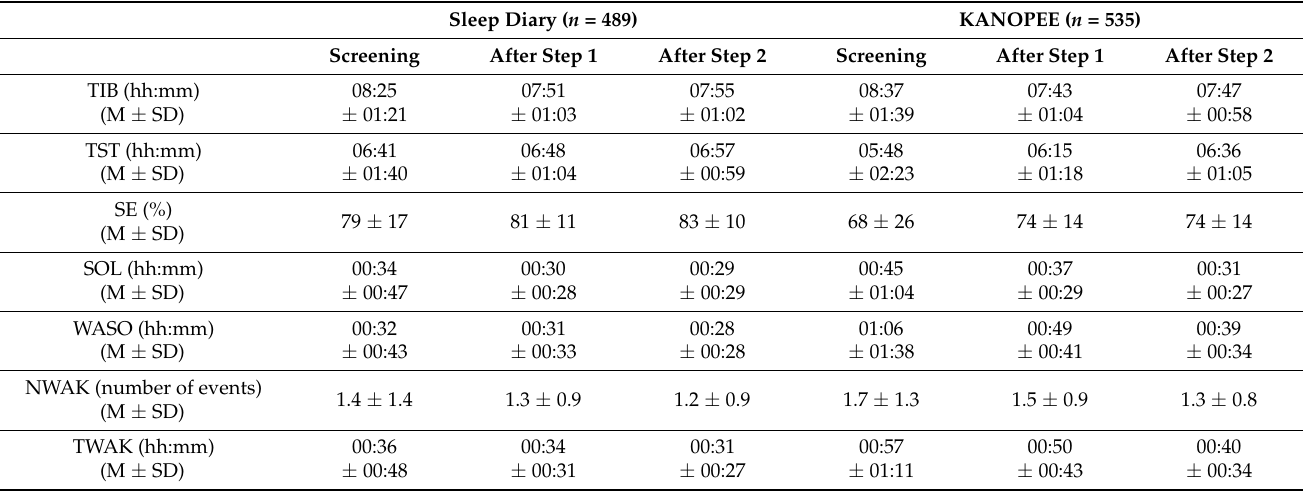
Table 2. Nocturnal sleep characteristics of participants on sleep diary and KANOPEE over time. Sleep Diary ( n = 489) KANOPEE ( n = 535) Screening After Step 1 After Step 2